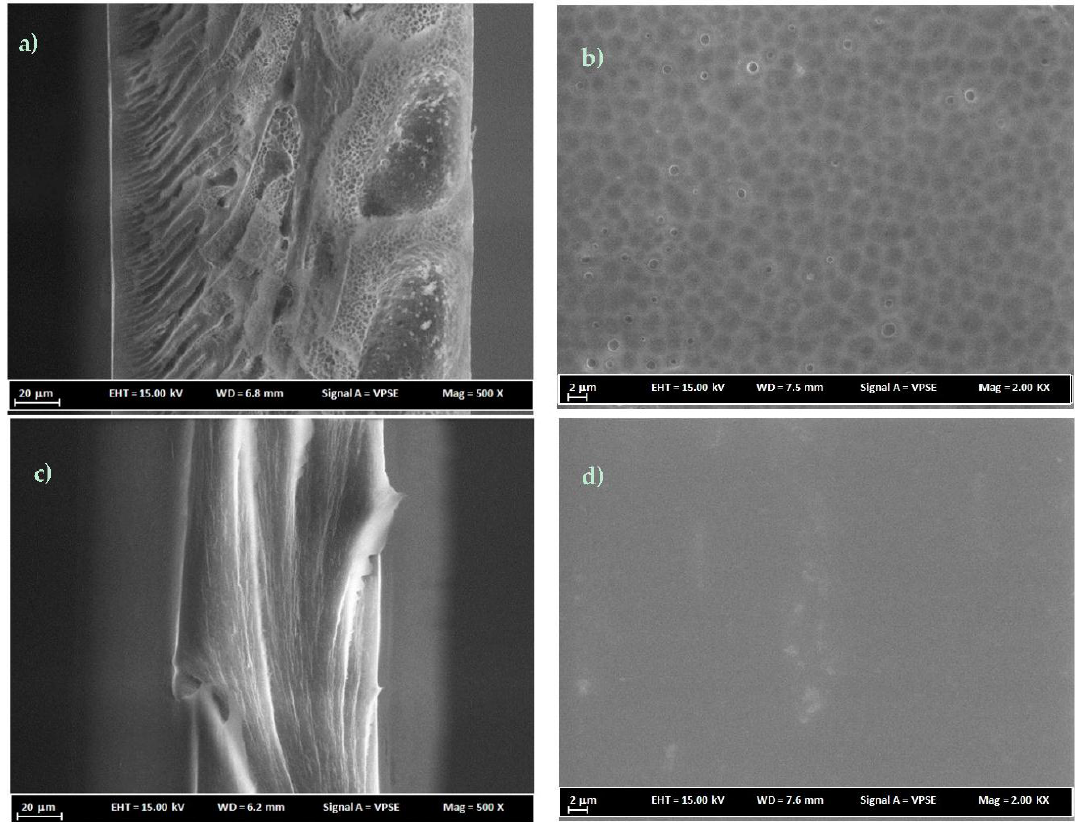
Figure 6. FESEM cross-sectional and surface images of membranes ( a , b ) 18 wt % PC/NMP and ( c , d ) 18 wt % PC/DCM.